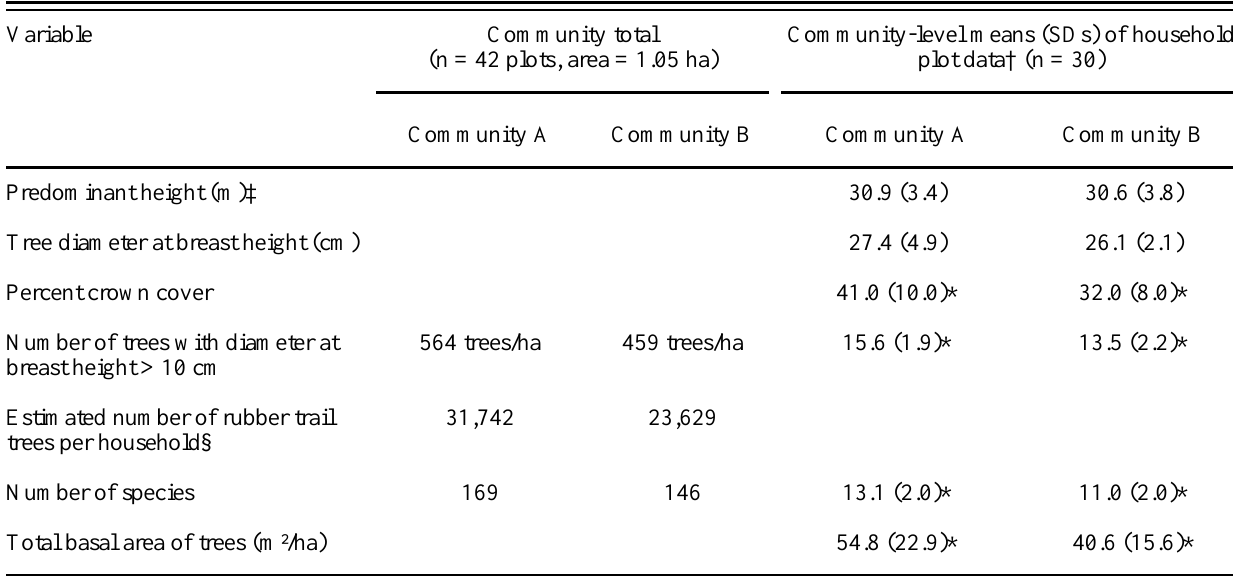
Table 5. Forest structure at community and household levels, as determined by forest inventory.